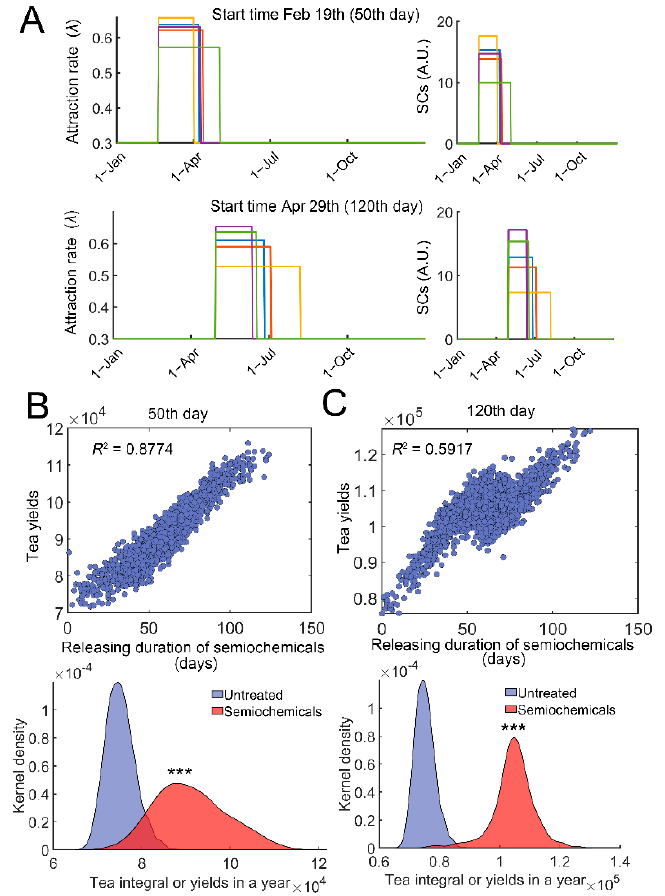
Figure 6. Evaluation of duration of semiochemical releases on tea crop integral (tea yields). ( A ) Examples of variations in attraction efficiency, λ and duration of release. λ = 0.3(1 + v max * SCs /( SCs + K m )), and SCs represent the current level of semiochemicals ( v max = 12, and K m = 12). The start time of semiochemical application was either 19 February (50th day, top) or Apr 29th (120th day, bottom). Five stochastic examples (blue, green, yellow, purple, and red squares) are shown. λ variations are shown on the left, and SCs variations are correspondingly provided on the right (curves with the same color). The total amount or dosage of semiochemicals was fixed at 720. The releasing duration was varied following a normal distribution D ~ N (60, 20), and D ∙ SCs = 720. ( B ) Correlation of tea yields after using semiochemicals with different durations of releases (Top). The start time was on the 50th day. Distributions of tea yields in the untreated group and group with semiochemical usage (bottom). ( C ) Similar to ( B ), the start time was on the 120th day. In each case, 2000 simulations were performed. ***: p < 0.0001.